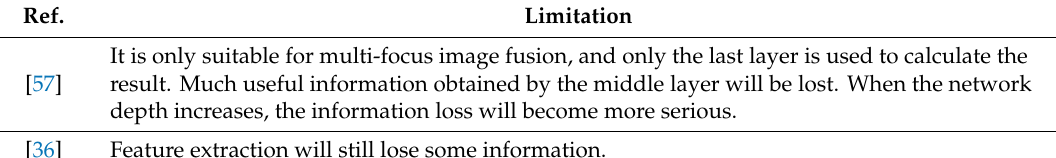
Table 2. The overview of some a convolutional neural network (CNN)-based fusion methods.